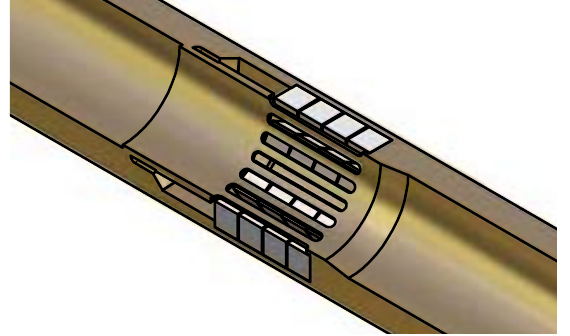
FIG. 11. (Color) The model of the bellows absorber (one quar-